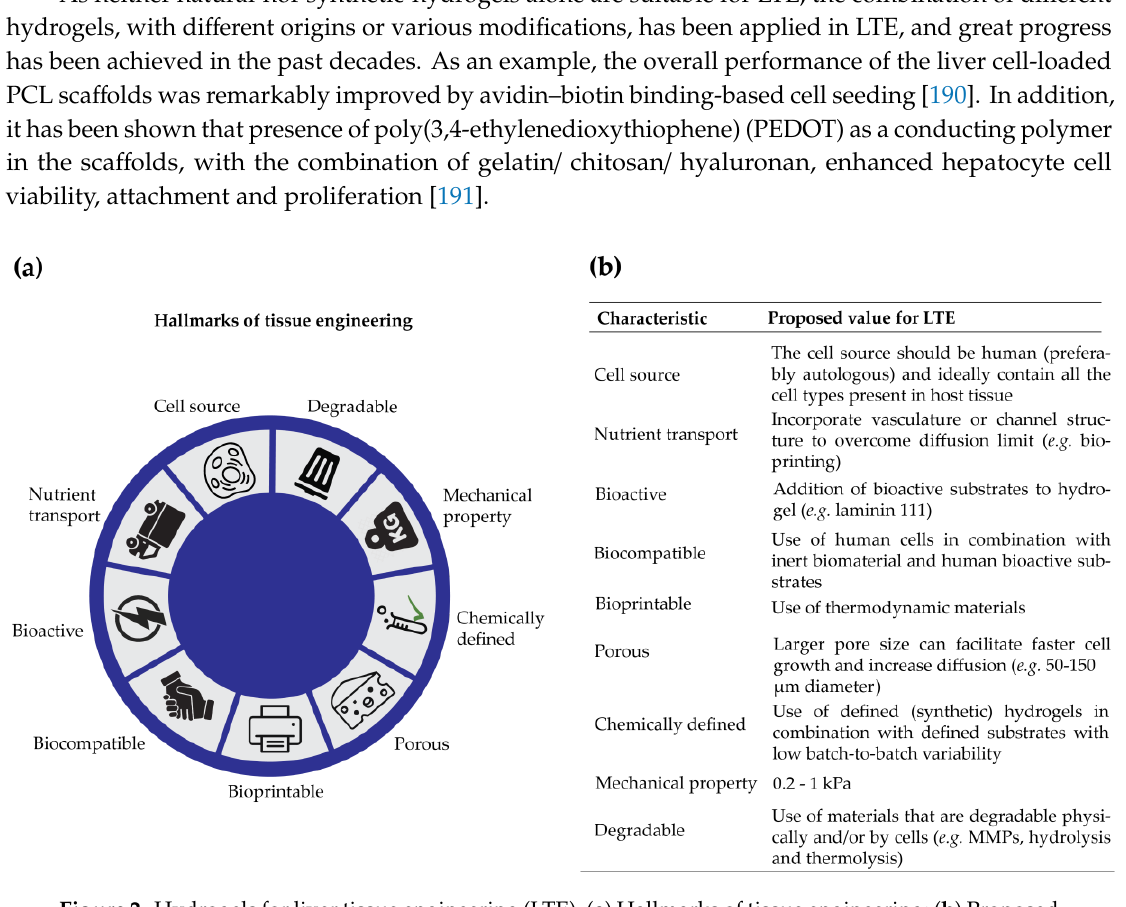
Figure 2. Hydrogels for liver tissue engineering (LTE). ( a ) Hallmarks of tissue engineering; ( b ) Proposed value of characteristics specific for LTE.